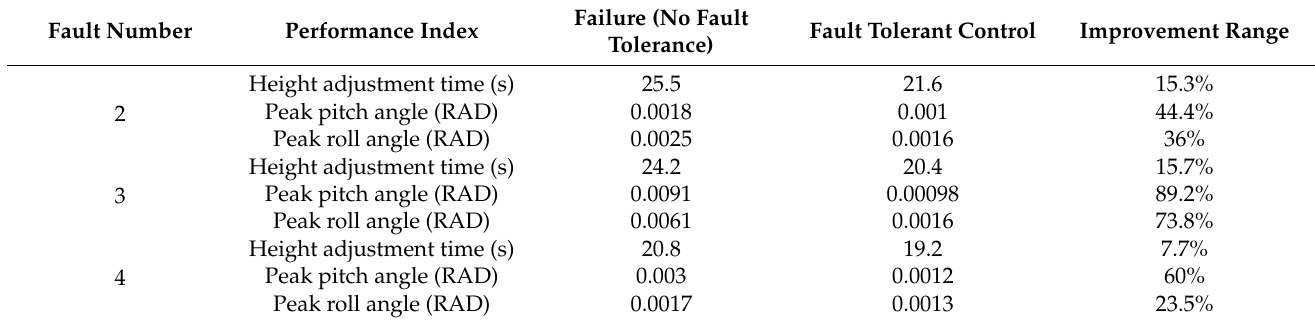
Table 6. HiL test result analysis of Faults